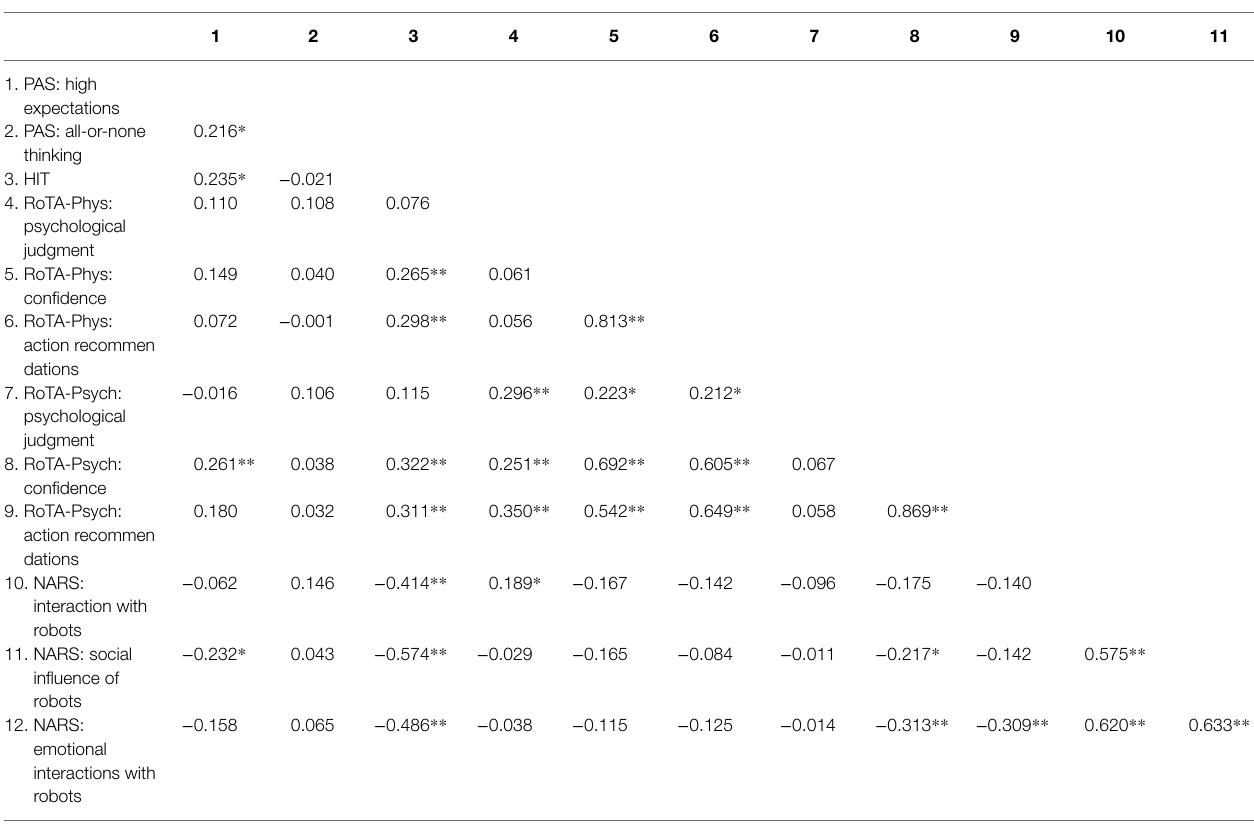
TABLE 3 | Intercorrelations of dispositional